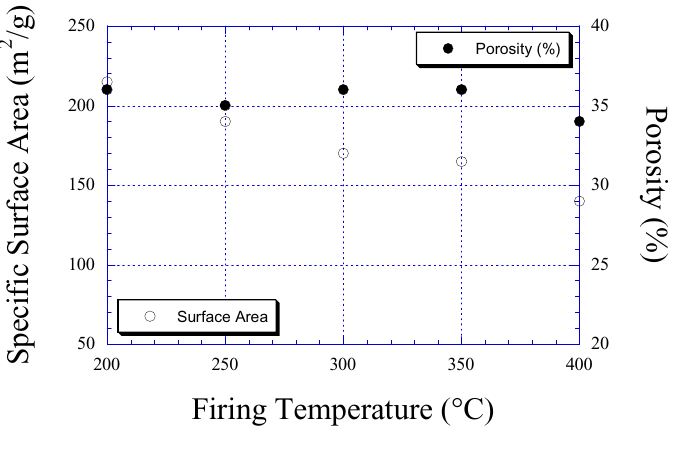
Figure 4. Effect of firing temperature on the porosity and surface area of Pt-TiO